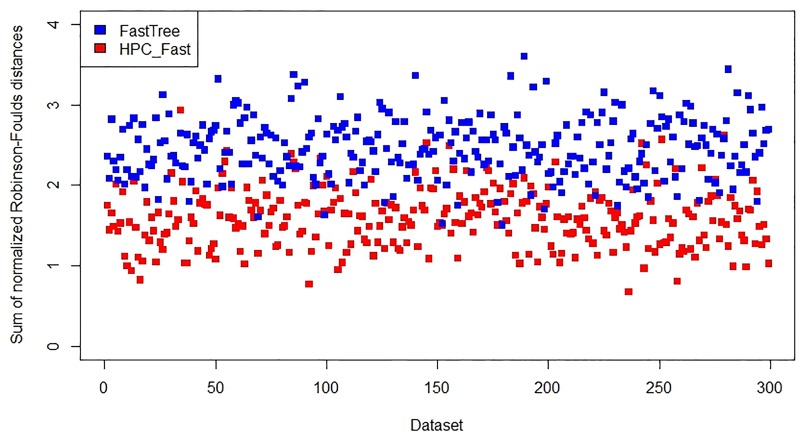
Accuracy assessment of FastTree and HPCFast on 300 Wide datasets.